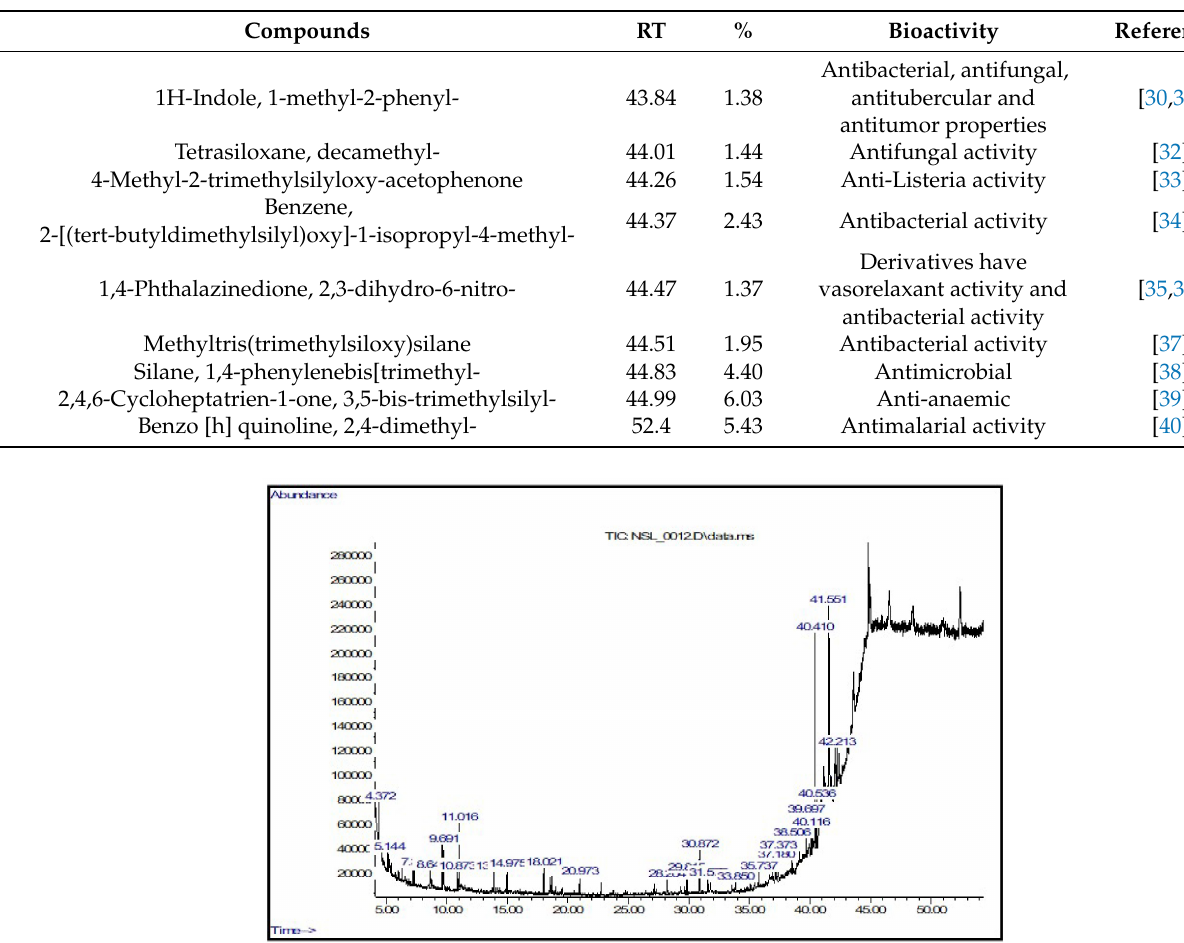
Figure 1. GC–MS traces of phytochemical constituents of M. oblongifolia methanolic extract.